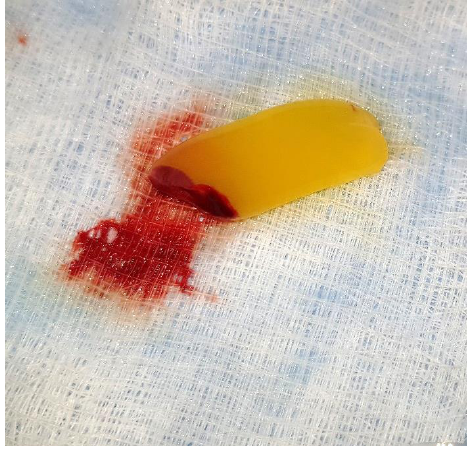
Figure 2: Platelet-rich fibrin When the centrifuge rotation nearly reach its ending, the tooth or the root (if the crown was